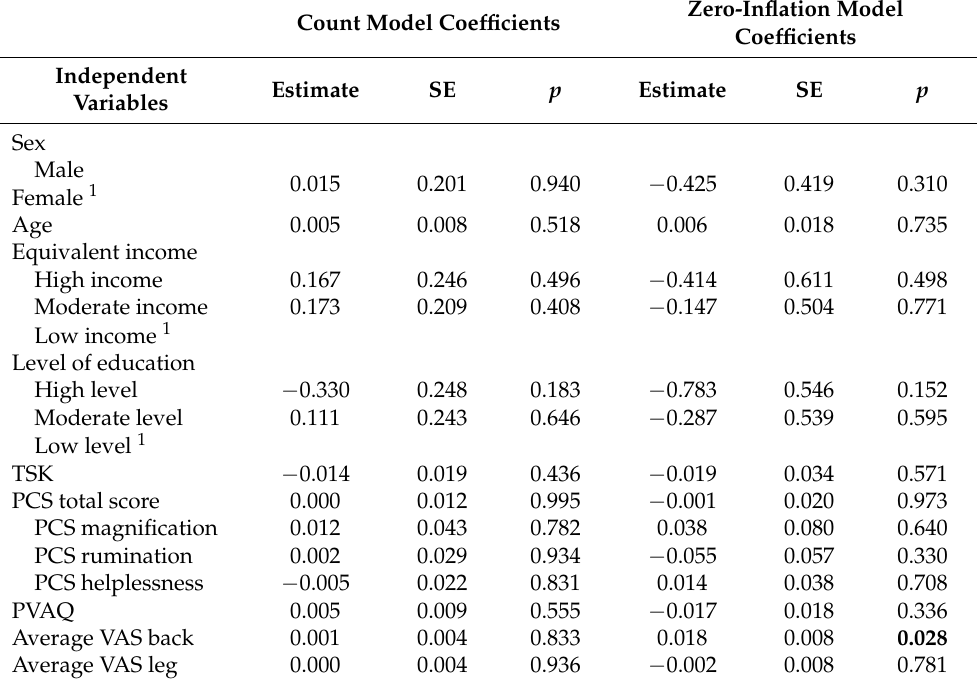
Table 3. Univariable Zero Inflation Models for the association between the number of physiotherapy visits and demographics, pain intensity and cognitions.